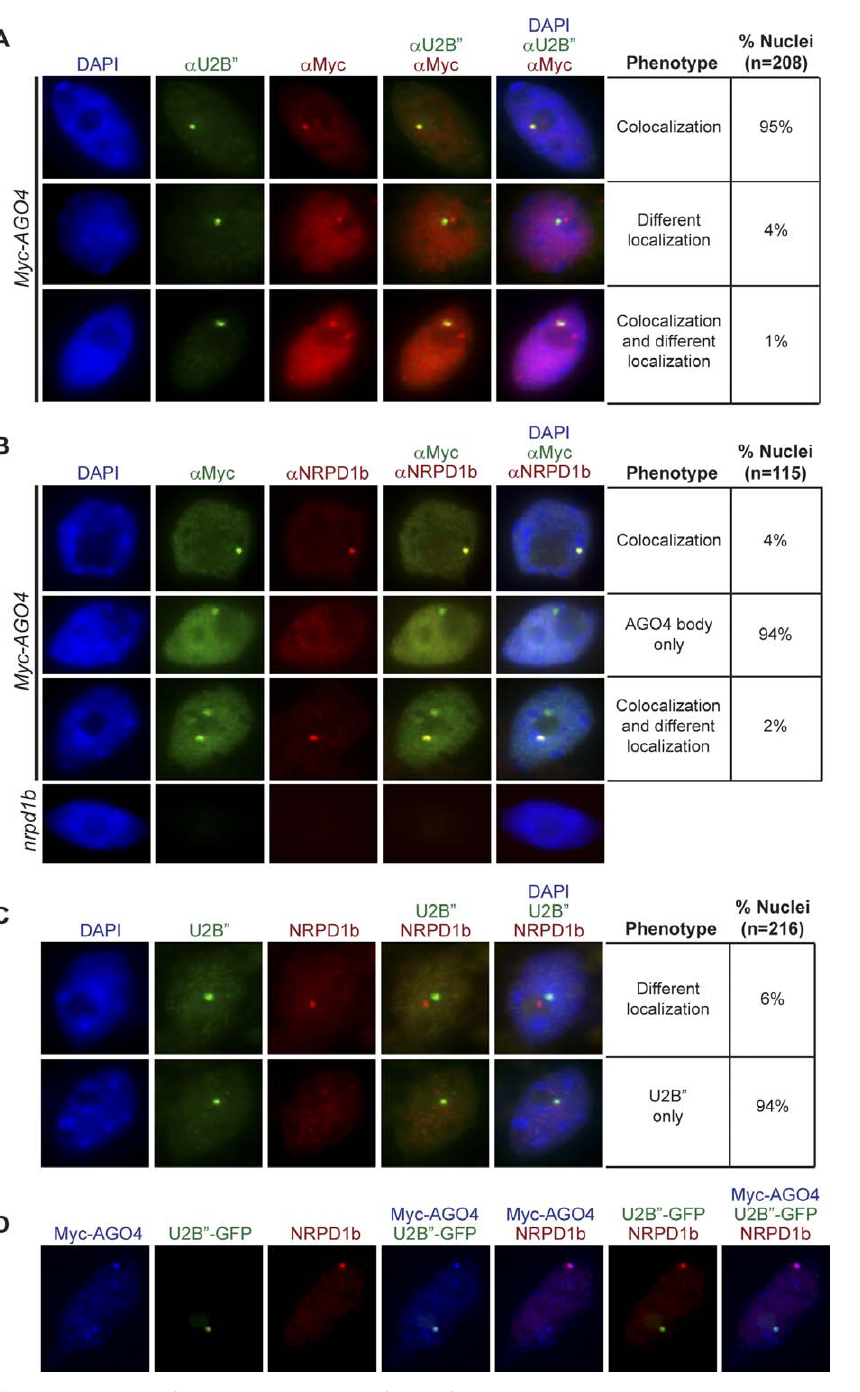
Figure 1. AGO4 Localizes to Two Distinct Nuclear Bodies (A) Fluorescent microscopy analysis of Myc-AGO4 and Cajal body localization in nuclei isolated from Myc-AGO4 seedlings. A monoclonal antibody to endogenous U2B 99 was used to detect the Cajal body. Three different AGO4 localization patterns relative to U2B 99 are shown. Nuclei containing observable AGO4 nuclear foci were examined. (B) Localization of Myc-AGO4 and NRPD1b in Myc-AGO4 nuclei. A polyclonal antibody was used to detect endogenous NRPD1b. Three representative nuclei are shown. Nuclei containing observable AGO4 nuclear foci were examined. (C) Localization of U2B 99 relative to NRPD1b within wild type Ler nuclei. (D) Three color fluorescent microscopy analysis of Myc-AGO4, U2B 99 -GFP, and NRPD1b localization within the same nucleus. One representative nucleus containing two different AGO4 bodies is shown: colocalization with NRPD1b (top of the nucleus) versus colocalization with the Cajal body (bottom of the nucleus). All AGO4 foci colocalized with either NRPD1b or Cajal body ( n ¼ 156).